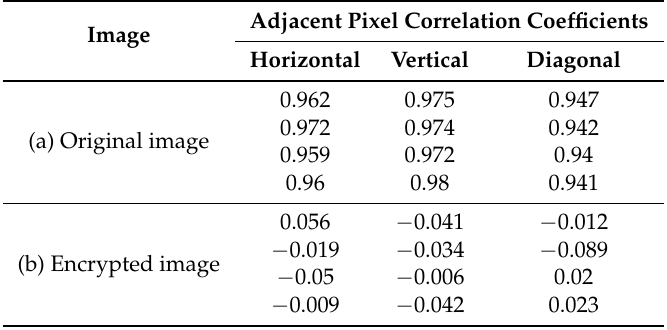
Table 5. Adjacent pixel correlation coefficients of the images in Figure